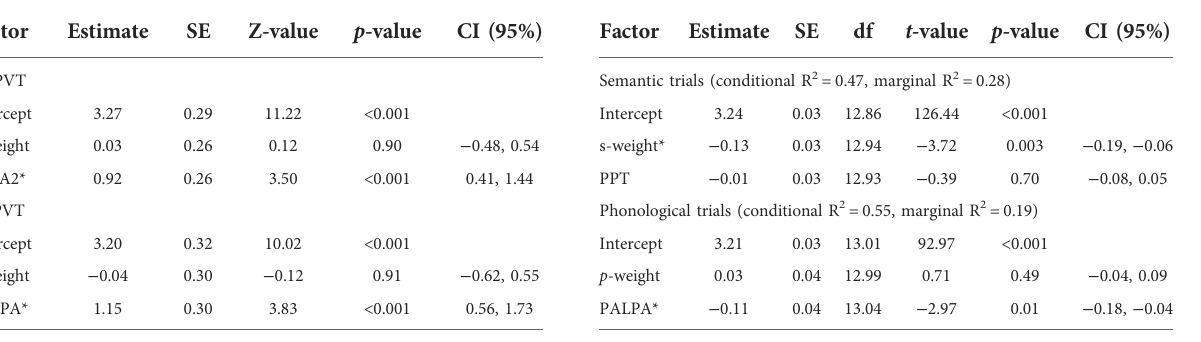
TABLE 7 Summary of rWPVT response latency linear mixed effect models.